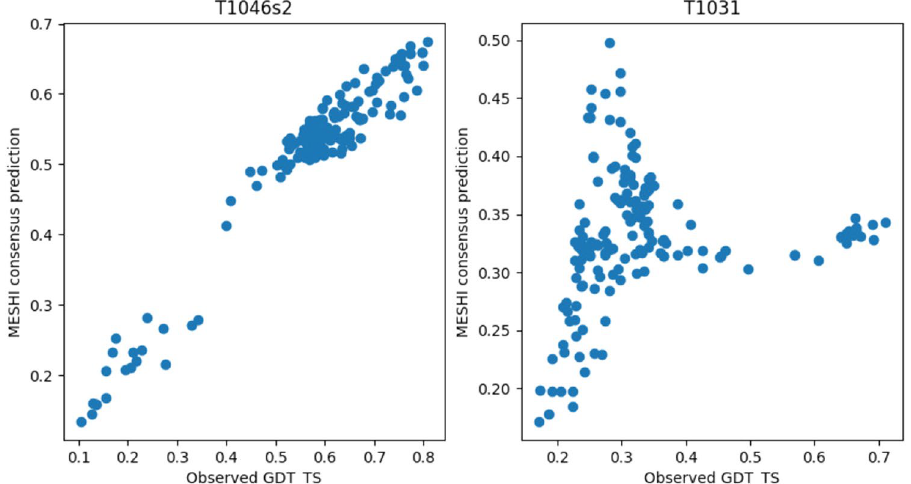
Figure 7. Examples of MESHI_consensus success and failure in CASP14. Predicted vs. observed qualities of models from two targets: Left: For target T1046s2 (PDB code: 6px4), MESHI_consensus reached a low RMSE (0.074) and the top-scoring model is indeed the best one (zero LOSS). Right: For target T1031 (PDB code: 6vr4) the RMSE is 0.128 and the best model ranked very low (LOSS is 0.428)